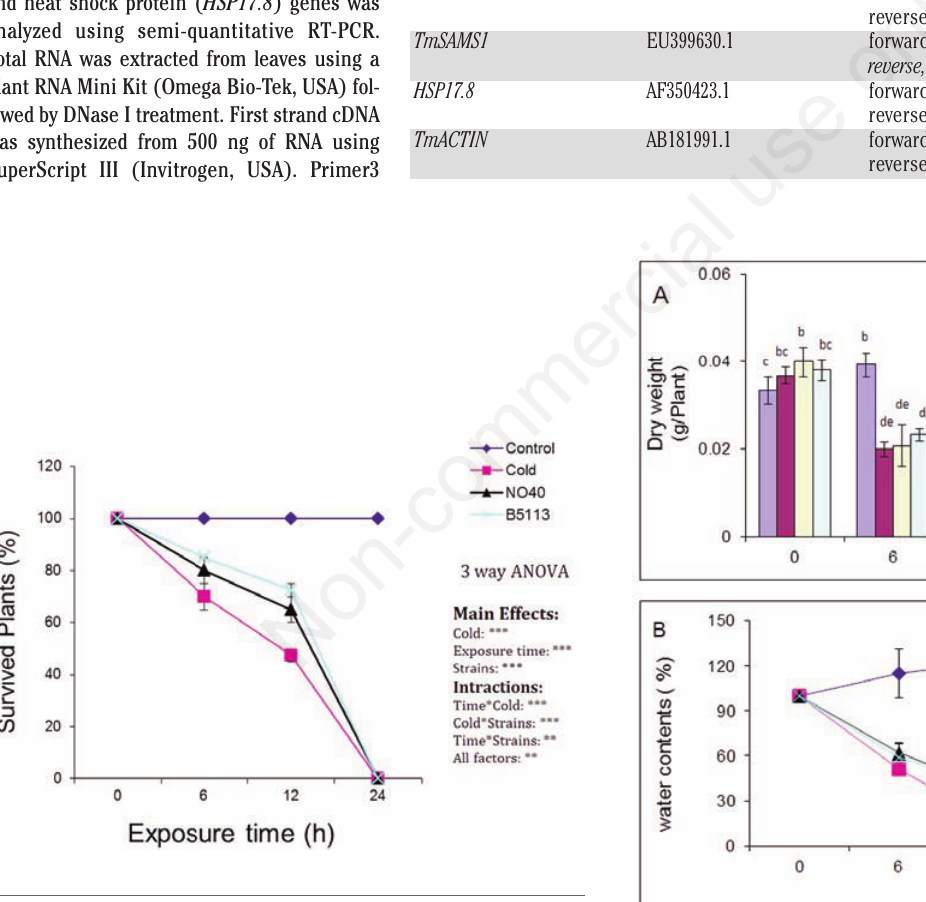
Figure 1. Effect of bacterial priming on plant survival of chilling stressed wheat. Bacterial priming with B. amyloliquefaciens 5113 or A. brasilense NO40 were tested for effects on the survival of wheat seedlings (cv. Sids1) subjected to −5°C 4 chilling stress for 0, 6, 12 and 24h. Bars indicate standard errors between tow plant groups with 20 replicates in each group. Statistical analysis based on 3 ways ANOVA was conducted on two plant groups with 20 replicates in each group. Three factors were considered for the analysis (stress, strains and stress exposure time). ***Indicates highly significant effect for the tested factor at P ≤ 0.01, **indi- cates significant effect for the tested factor at P ≤ 0.05.